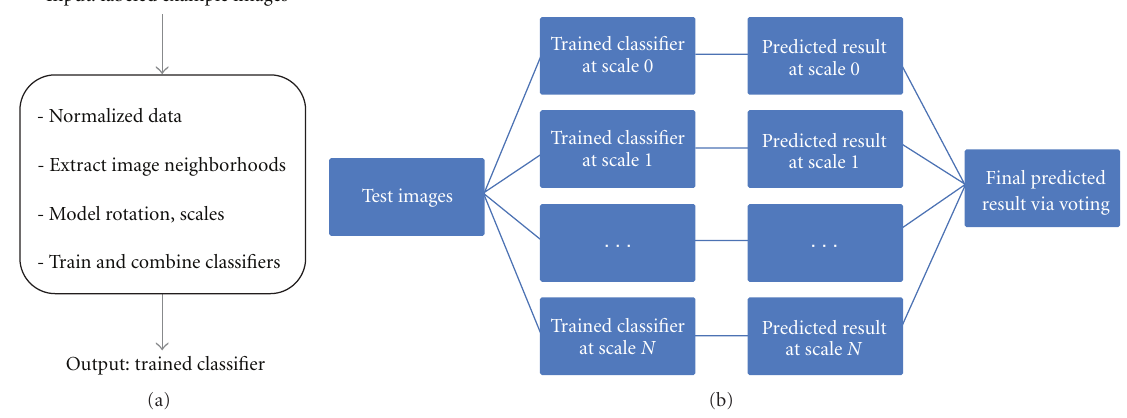
Figure 1: System schematic organization for neighborhood-based image segmentation using supervised learning (a), training stage (b), and testing